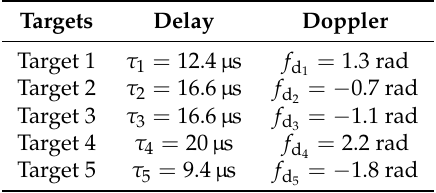
Table 3. Locations of the simulated